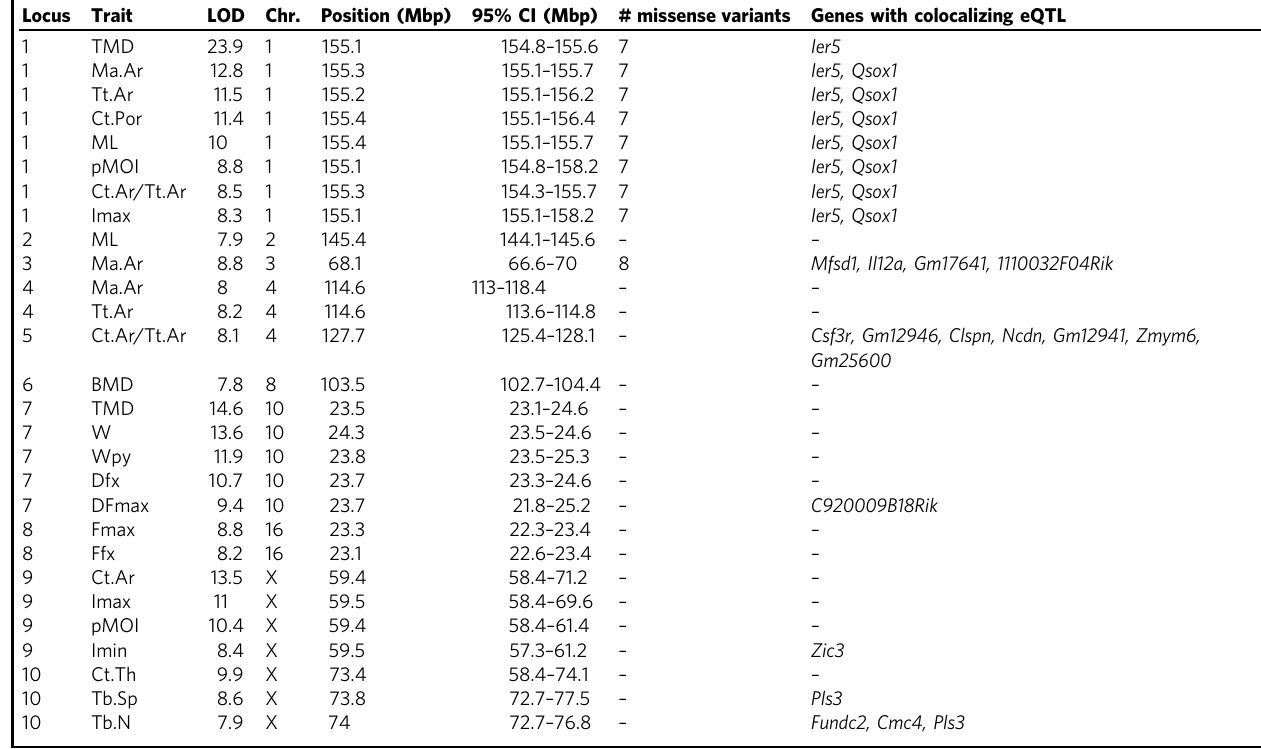
Table 1 QTL identi fi ed for complex skeletal traits in the DO. Locus